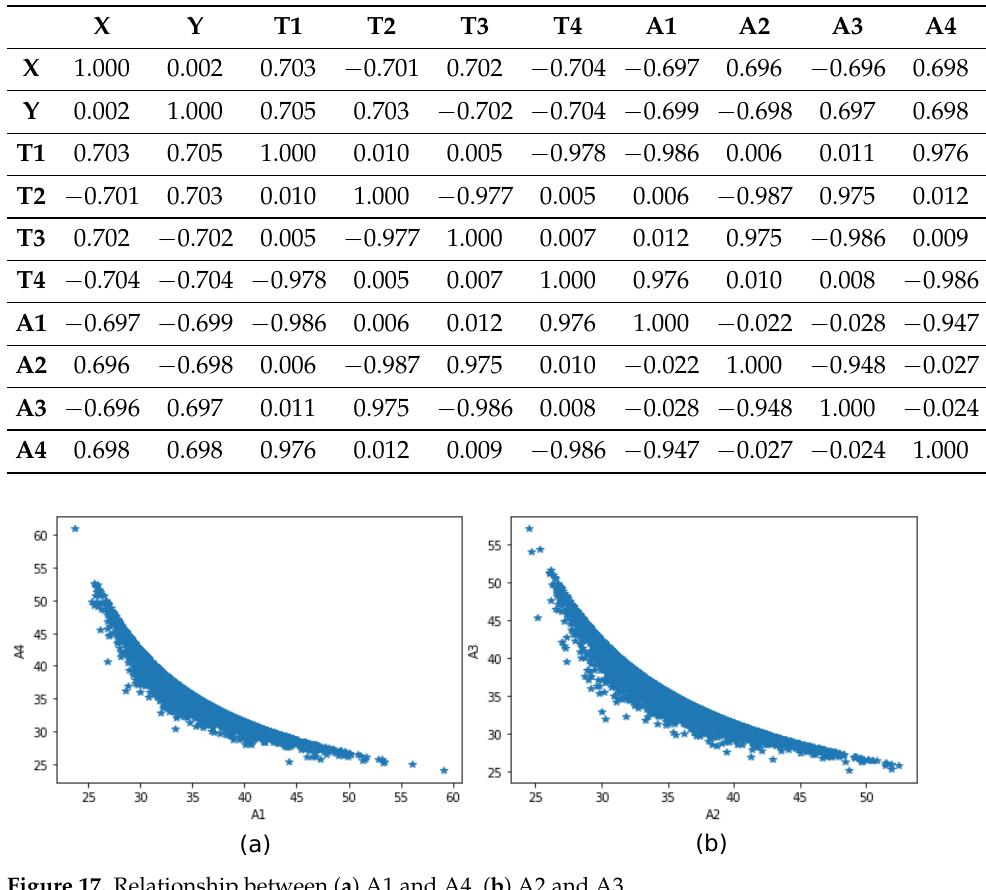
Figure 17. Relationship between ( a ) A1 and A4, ( b ) A2 and A3